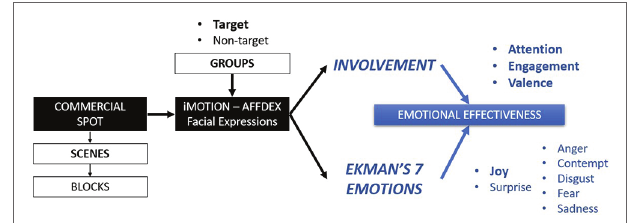
FIGURE 1 | Framework to quantify emotional effectiveness by target group and/or blocks of